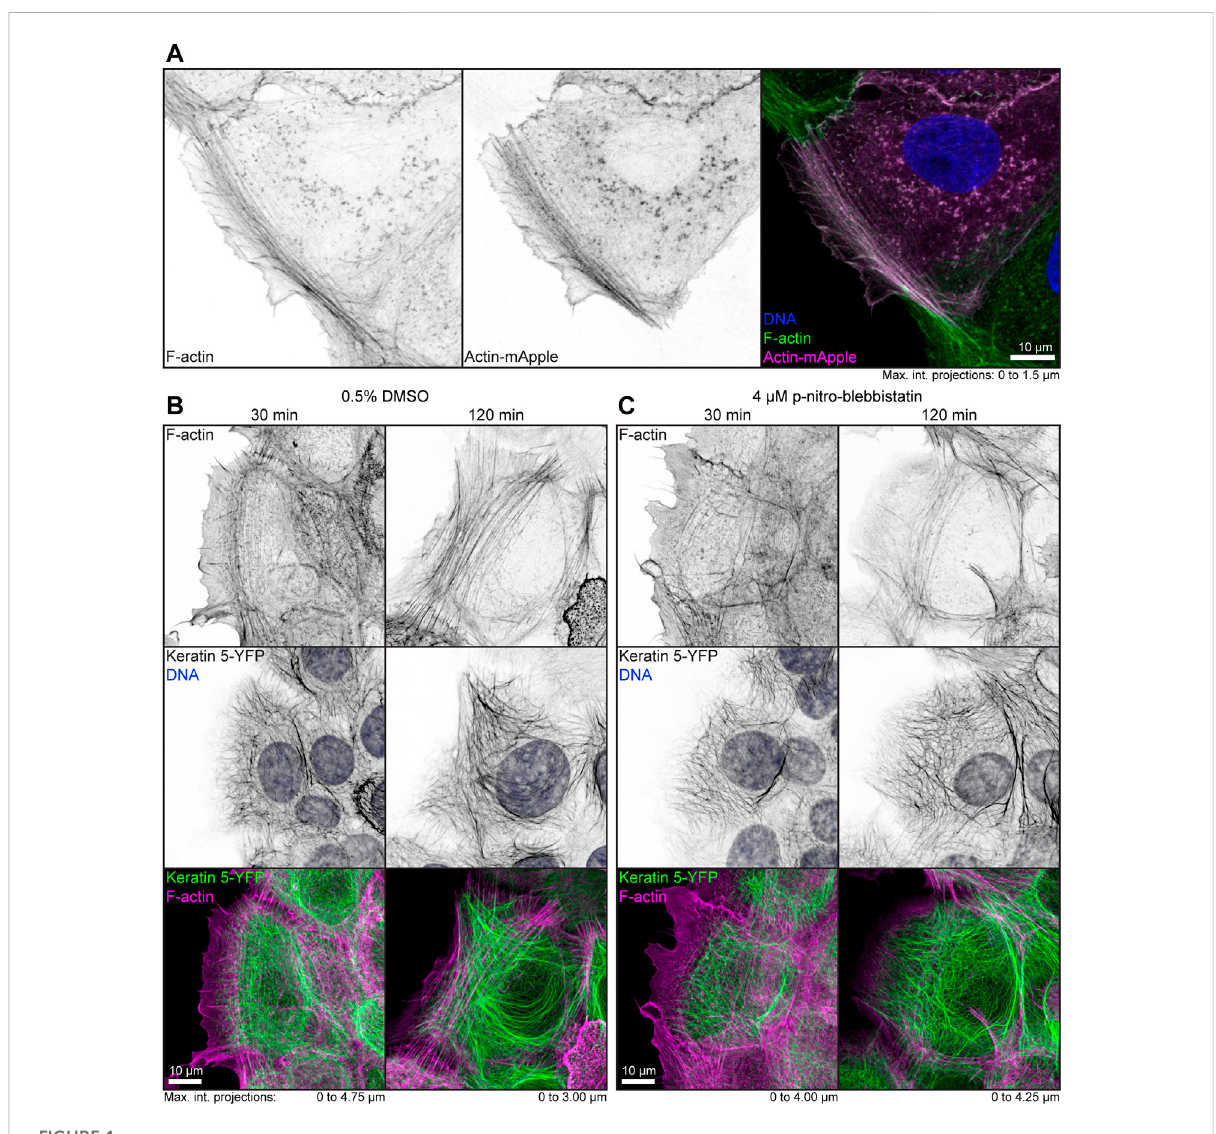
FIGURE 1 Low dose para-nitro-blebbistatin treatment does not affect the overall organization of the actin and keratin cytoskeleton. The fl uorescence micrographs show maximum intensity projections of fi xed HaCaT keratinocytes. (A) illustrates co-localization of Alexa-488-tagged phalloidin (F-Actin; left) and Actin-mApple fl uorescence (middle). The overlay of both (right) reveals overlapping distribution of fi lamentous actin but not of cytoplasmic non- fi lamentous actin that is only detectable with Actin-mApple. (B,C) The images show the distribution of Alexa-647-tagged phalloidin (F-Actin; top) together with keratin 5-YFP and DAPI (DNA; middle; co-localization of actin and keratin in lower panel) in HaCaT B10 cells. Notethattheactinandkeratincytoskeletonarenotsigni fi cantlyaffectedbya30 – 120 mintreatmentwith0.5%DMSO (B) andthatcellsremained fl at and well spread even after addition of para-nitro-blebbistatin (4 µM) presenting a normal-appearing actin and keratin cytoskeleton